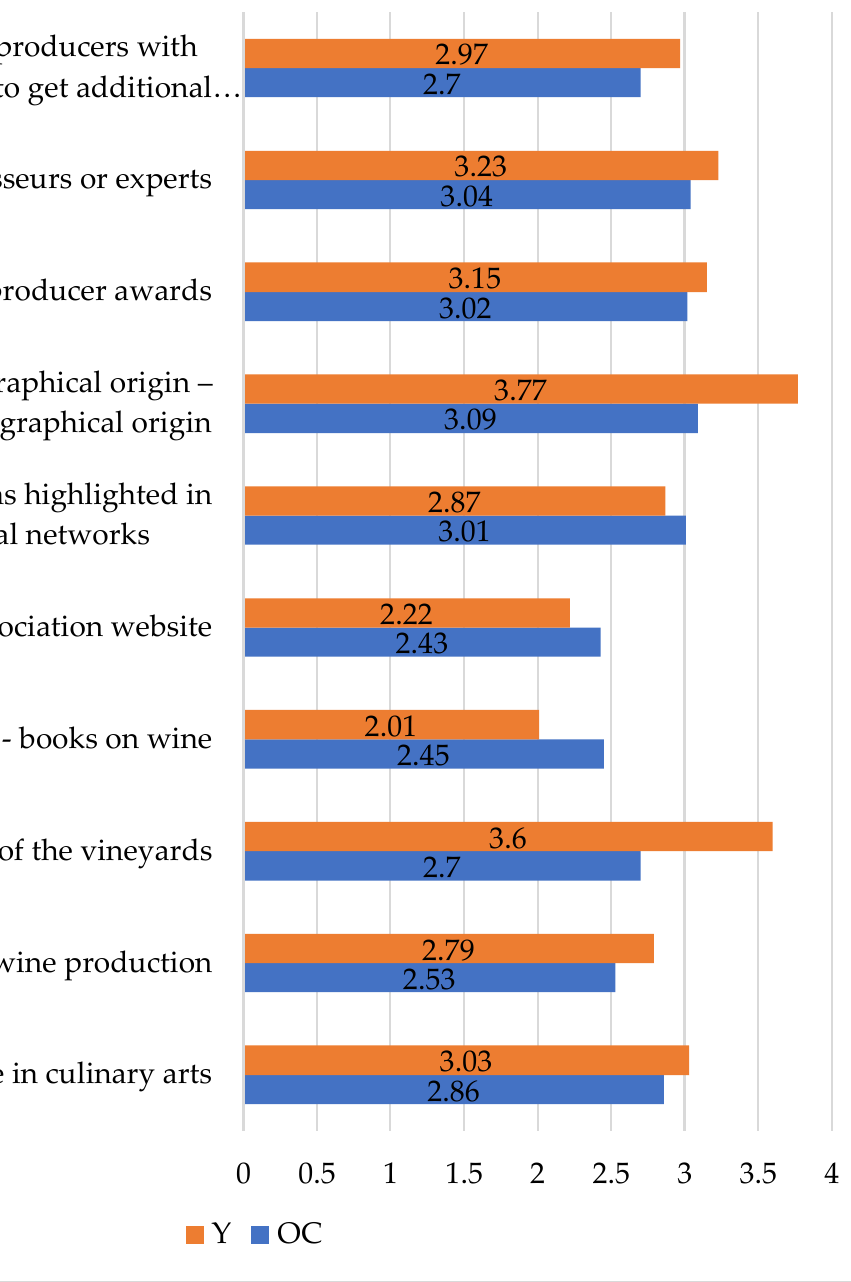
Figure 1. Importance of online wine information in online wine purchase.